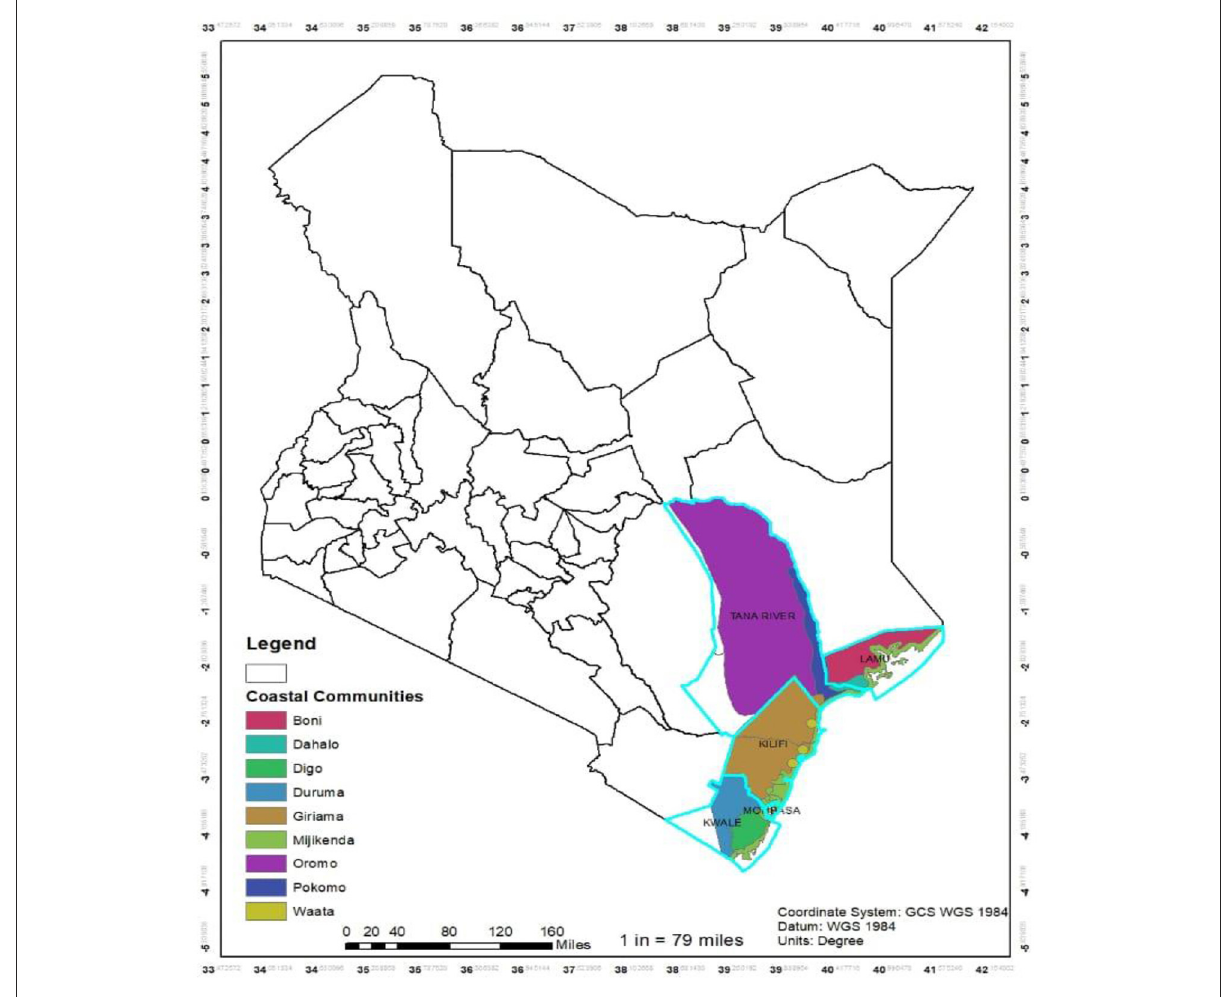
FIGURE1 A coastal color map representation of ethnic indigenous communities in